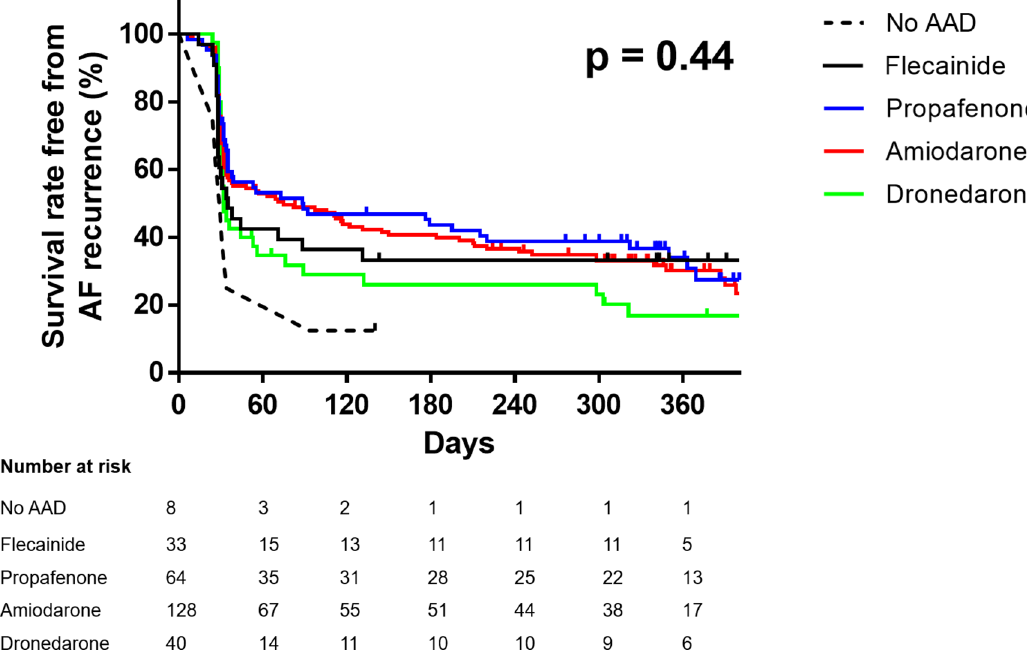
Fig 2. Kaplan-Meier curve for recurrence of atrial fibrillation during the first year after electrical cardioversion according to antiarrhythmic drug type. AF indicates atrial fibrillation; AAD, antiarrhythmic drug. P value as calculated by the log-rank test between the 4 AAD groups. ‘No AAD group’ is shown for reference only.